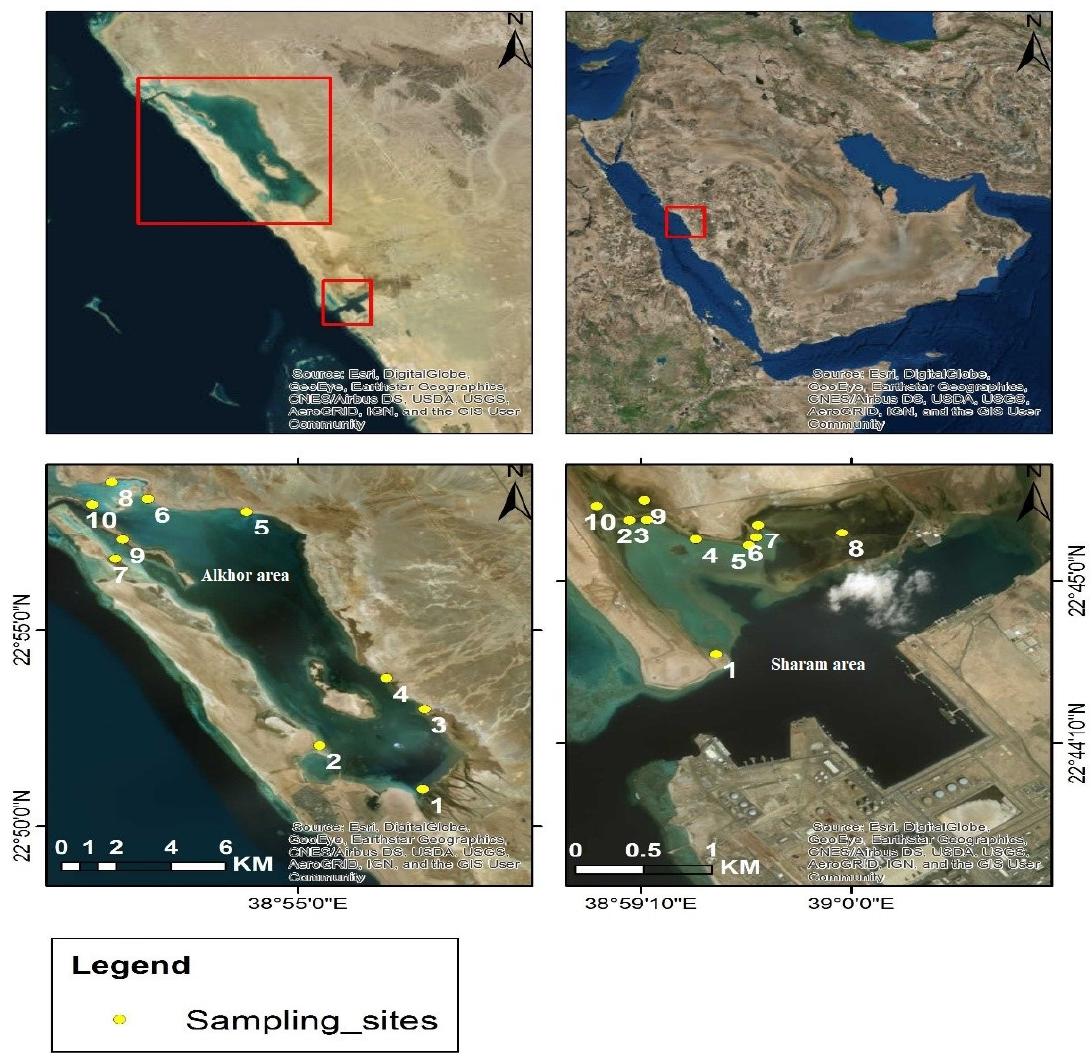
Figure 1. Map of the study areas (Alkhor area and Sharam area) showing the locations of sample collection sites.